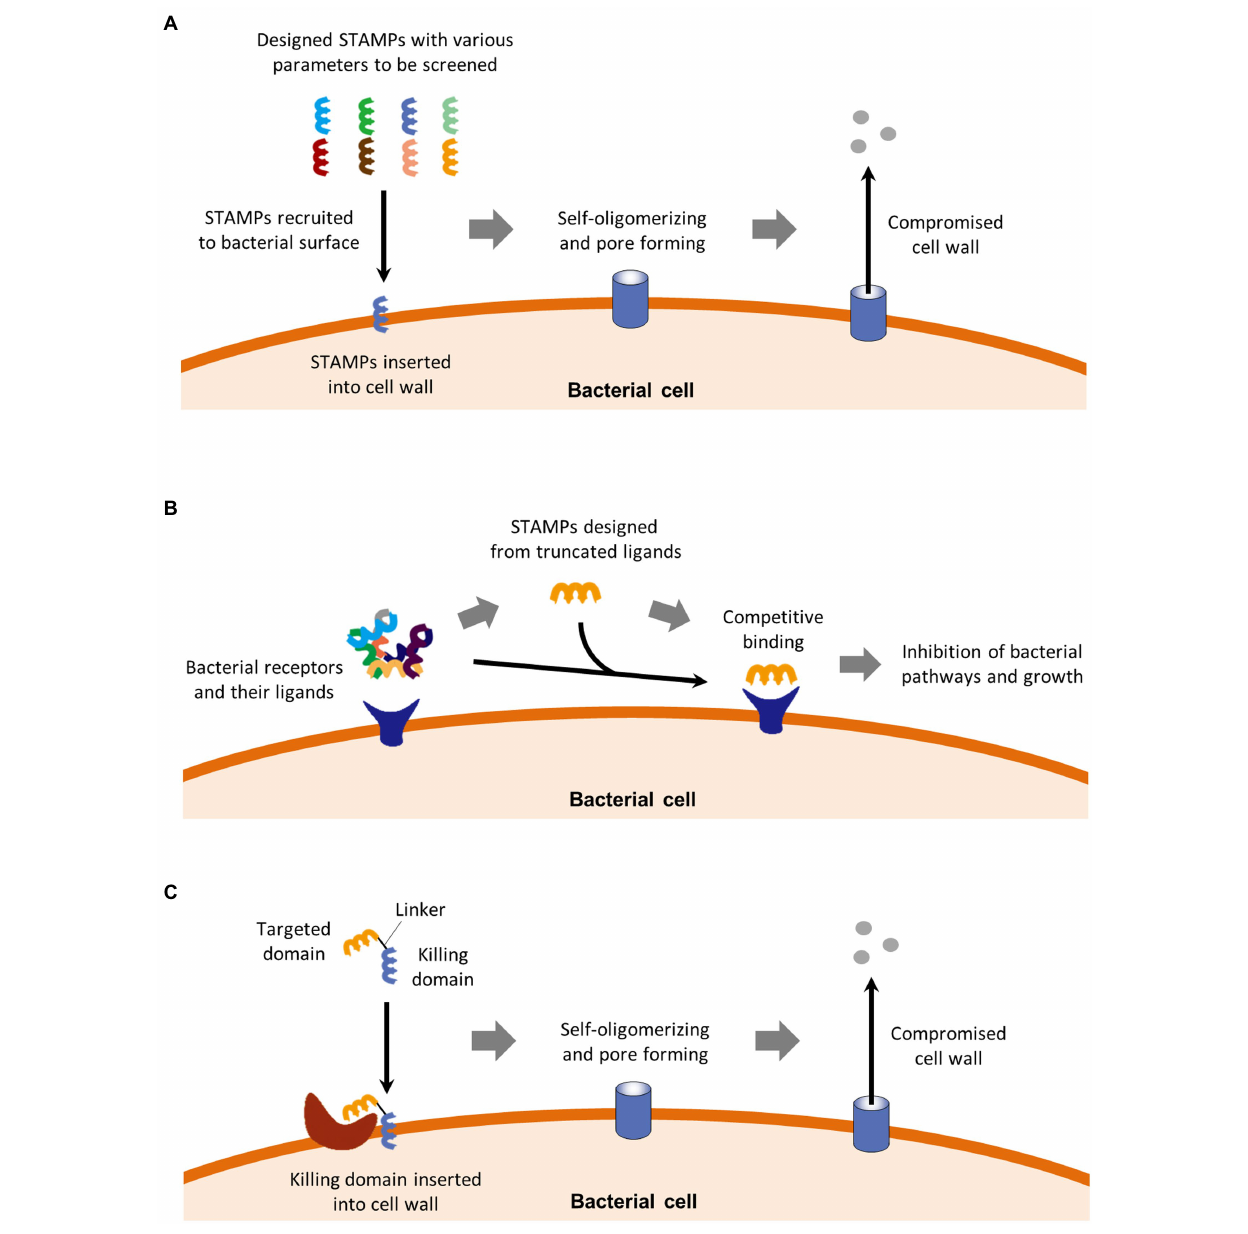
FIGURE 2 | STAMPs can be divided into three categories. (A) Canonical STAMPs are usually discovered by screening a batch of peptides with various parameters including hydrophobicity, cationic number, and secondary structure. These parameters, as well as some bacterial factors, determine the affinity between the peptides and bacterial surfaces. Canonical STAMPs kill bacteria by insertion into the cell membrane, followed by self-oligomerization, pore formation, and cell membrane perturbation. (B) Peptide ligands as STAMPs. This category of STAMPs kills specific bacteria by competitively binding bacterial receptors of physiological importance against the natural ligands of the receptors, resulting in inhibition of important bacterial pathways and subsequential inhibition of bacterial growth. (C) Composite STAMPs consist of a targeted domain and a killing domain. The targeted domain binds to specific motifs on targeted bacteria, which directs the killing domain to kill bacteria in the same way as canonical